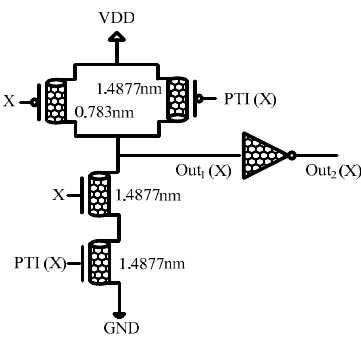
Table 2. Truth Table of Ternary NTI, PTI, Out1, and Out2.